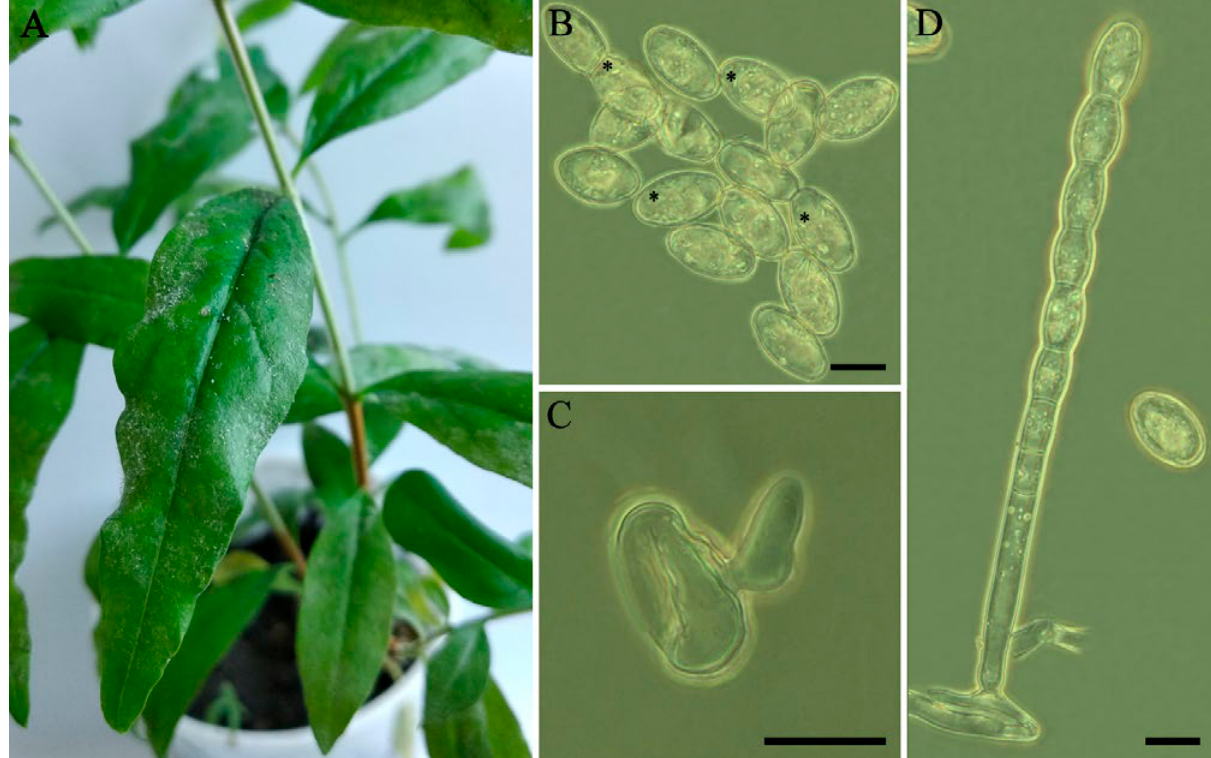
Figure 2. Podosphaera xanthii on Punica granatum . A: White colonies of P. xanthii on Pu . granatum . B: conidia, asterisks show fibrosin bod- ies. C: germinated conidium. D: conidiophore. Bars = 25